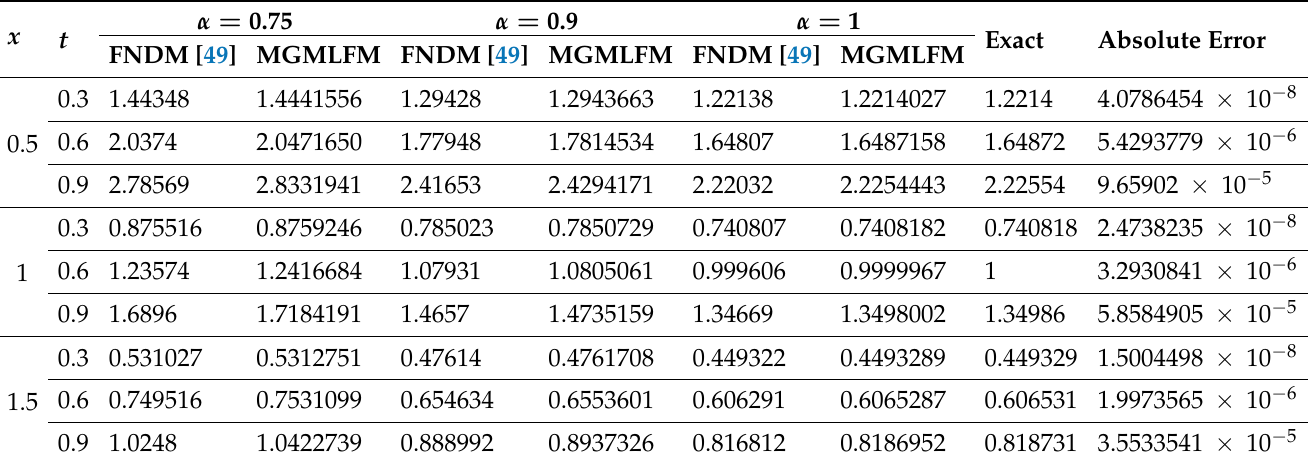
Table 6. Values of approximate solutions obtained by MGMLFM, FNDM, exact solution, and absolute errors of W for system (5) with various values of α , t , x and y = 0.4.